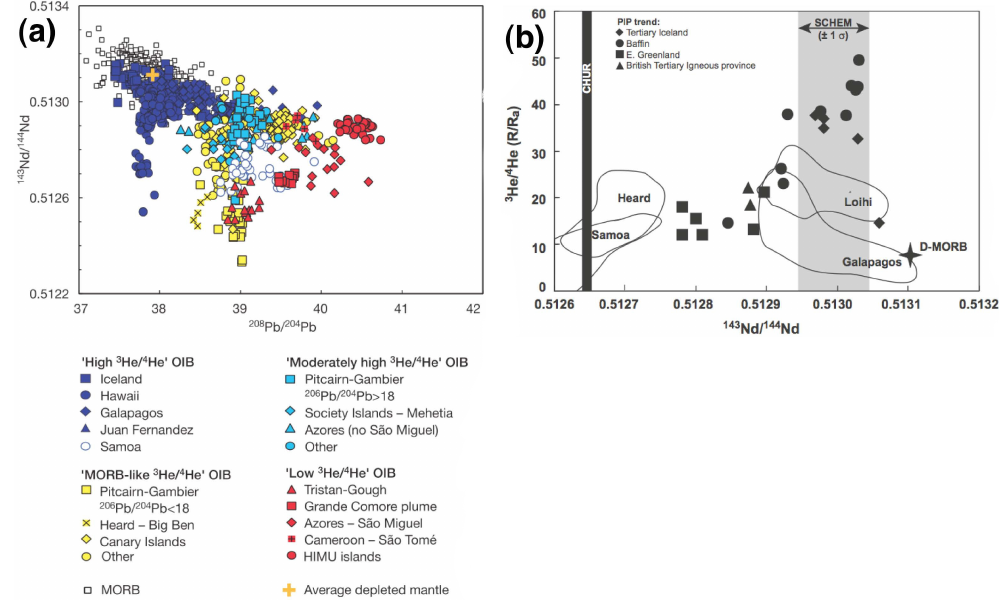
Fig. 17. Nd–Pb–He isotopes of OIB and MORB. (a) High 3 He/ 4 He OIB have the relatively a depleted Nd signal and low Pb isotope ratios. From Class and Goldstein (2005). Reprinted from Nature with permission. Copyright Macmillan Magazines Ltd. (b) The highest 3 He/ 4 He are associated with Nd isotopes corresponding to the “super-chondritic Earth model” (SCHEM) inferred from 142 Nd isotopes, and thus inferred to be primitive. From Caro and Bourdon (2010). Copyright Elsevier Science. Reprinted with permission.